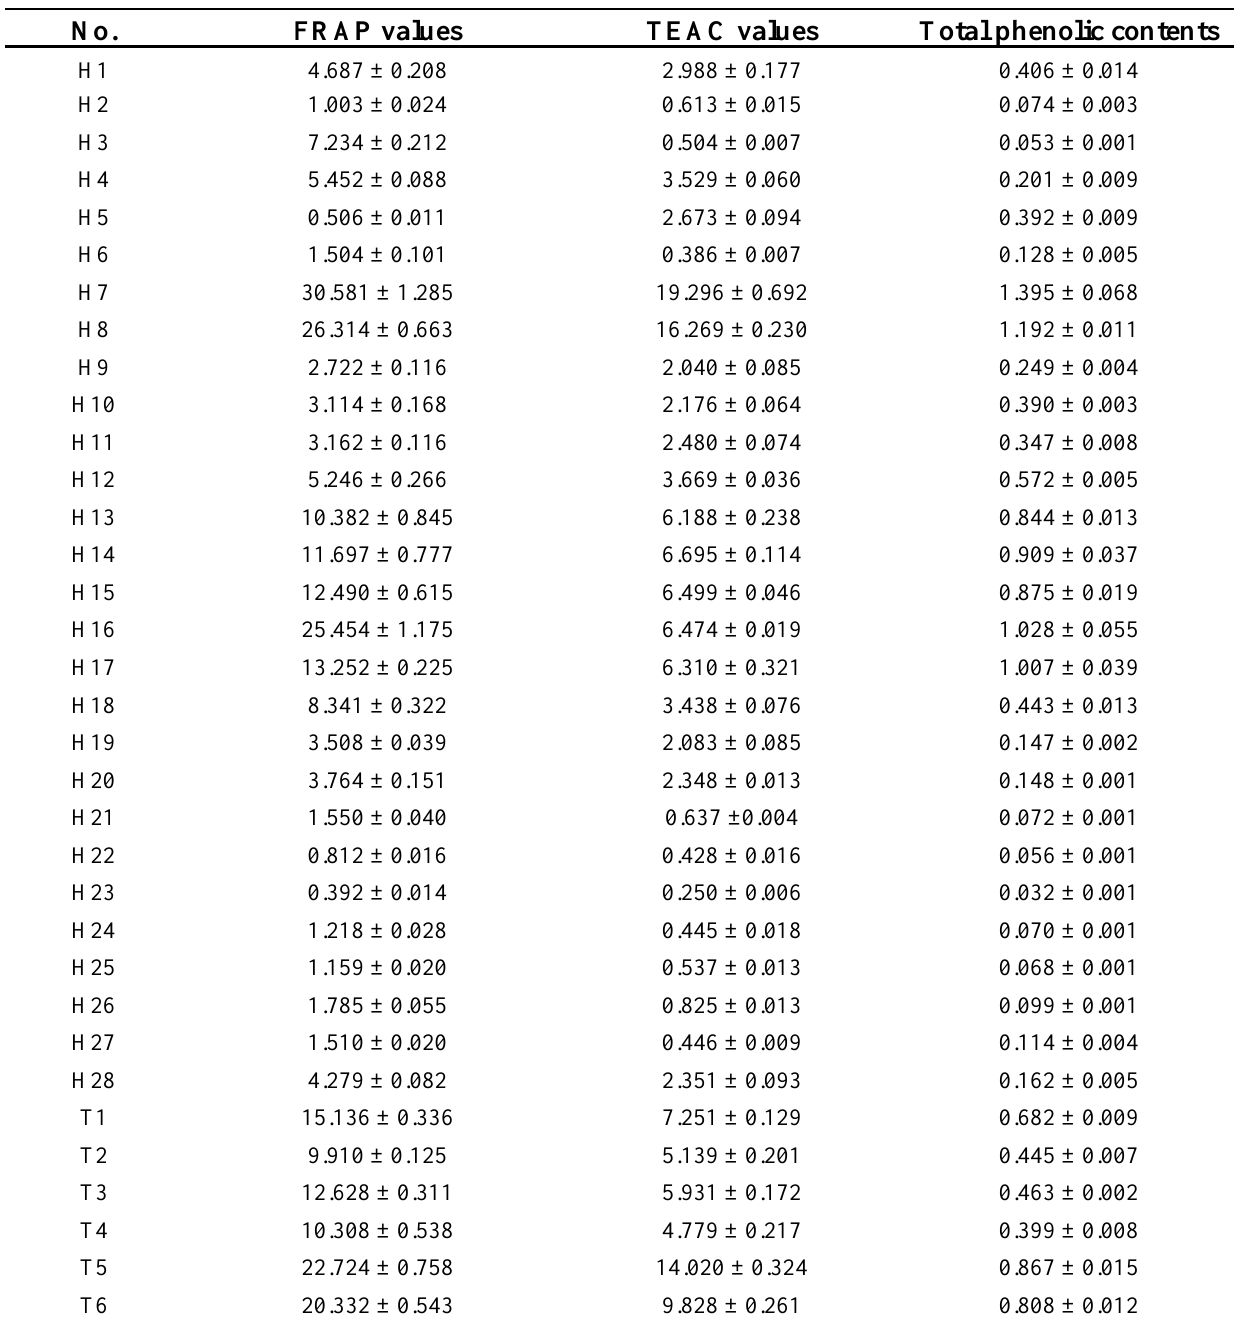
Table 2. The antioxidant capacities and total phenolic contents of 51 herbal and tea